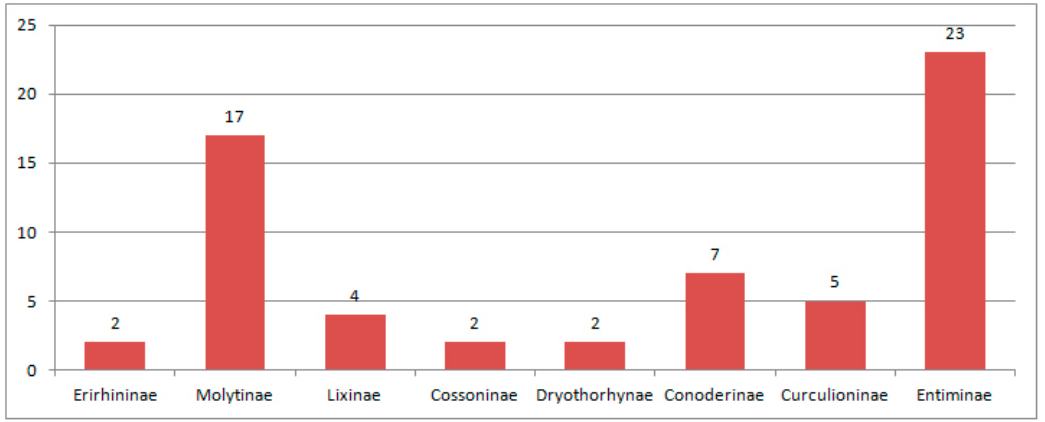
Figure 23. Composition of species of Curculionidae in the Oligocene.